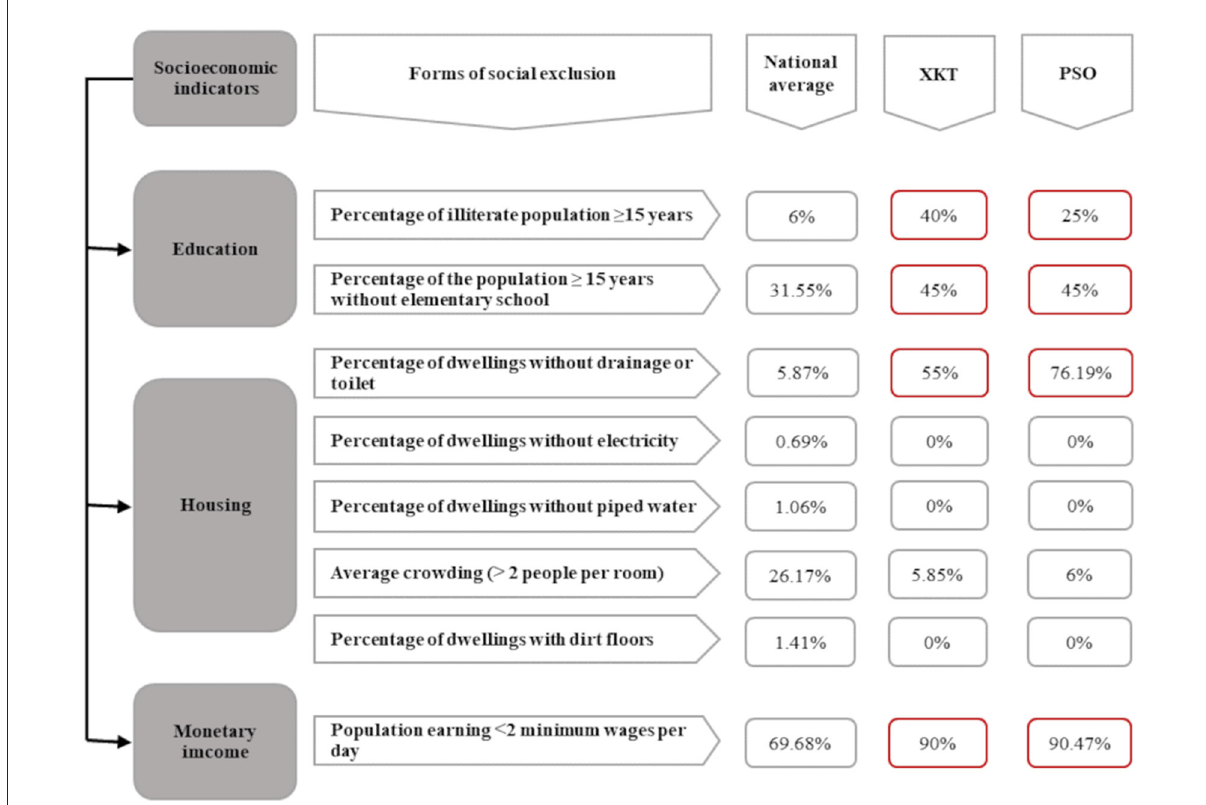
FIGURE2 Conceptual scheme of social marginalization of two Mayan communities of Yucatan, México. Here we compared the national average of each of the exclusion forms, design for the National Population Council of Mexico to measure social marginalization (20), with the two Mayan communities studied. We can observe in red the collected data that exceeds the national average. XKT, Xkalakdzonot; PSO,